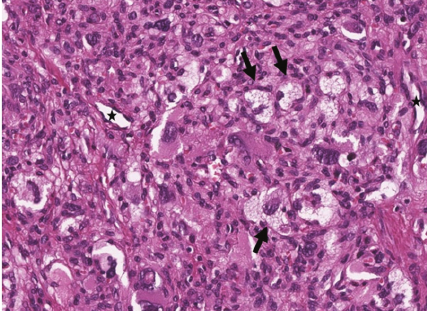
Figure 3: Histology (300x, H & E stain) showed a solid tumor with interspersed lipoblasts (arrow) and prominent small vessels ( ∗